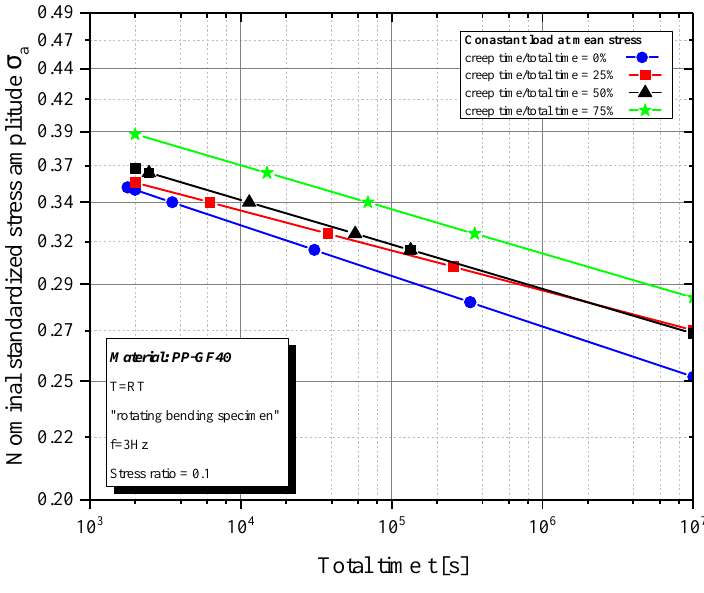
Figure 7. Time to failure for constant load at mean